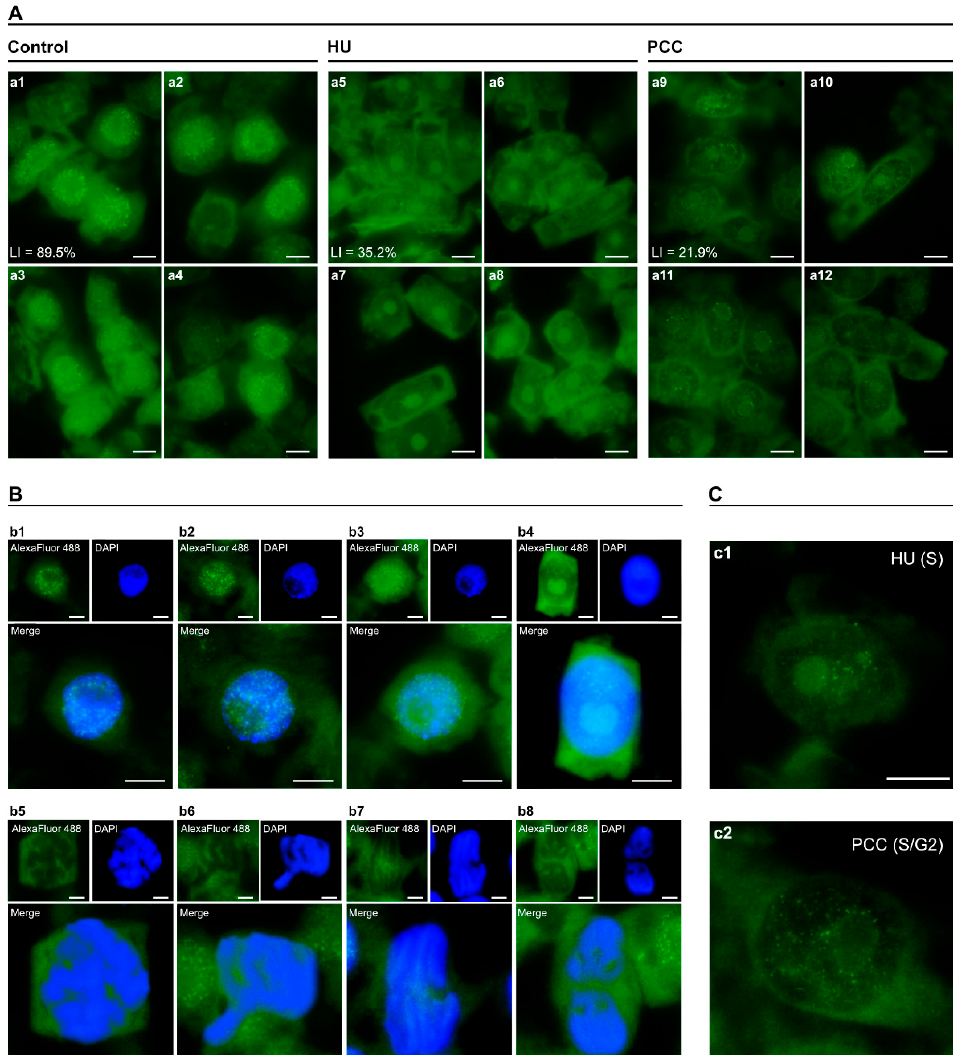
Figure 2. ( A ) The visible changes in activity of RbS807/811ph in interphase cells from control ( a1 – a4 ), HU-treated ( a5 – a8 ), and PCC-treated ( a9 – a12 ) series. The protein foci are significantly less visible after incubation with HU, but the pRb’s activity is moderately increased in PCC-type cells, which suggests the reactivation of Rb phosphorylation. LI stands for Labeling Index. ( B )Representative images of cell cycle progression: b1 —G1-phase; b2 —early S-phase; b3 —late S-phase; b4 —G2-phase; b5 —prophase; b6 —metaphase; b7 —anaphase; b8 —telophase. Large images are the joined photographs of nuclei, the blue and green channels were added to each other. ( C ) The closeup images of HU-treated cells ( c1 , S-phase) and HU/CF-treated cells ( c2 , S/G2-phase), showing the differences in the number, localization, and luminescence of singular foci. The cells were stained with AlexaFluor 488 (green fluorescence) and DAPI (blue fluorescence). The scale bar is approx. 10 µm.